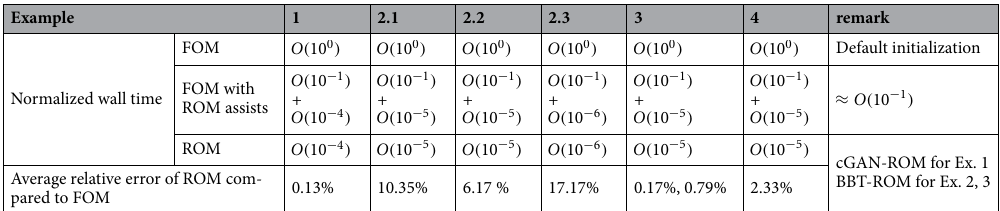
Table 3. Summary of normalized wall time magnitude and relative error of ROM. ROM uses much less computational time (at least four orders of magnitude less) than the FOM nonlinear solver; hence, using ROM to assist FOM reduces a computational cost by one order of magnitude. Normalized wall time is calculated by normalizing each wall time used by the highest wall time (i.e., FOM with default initialization). For Example 3, there are two primary variables, p h and s h ; therefore, we report two relative error values for these two variables,